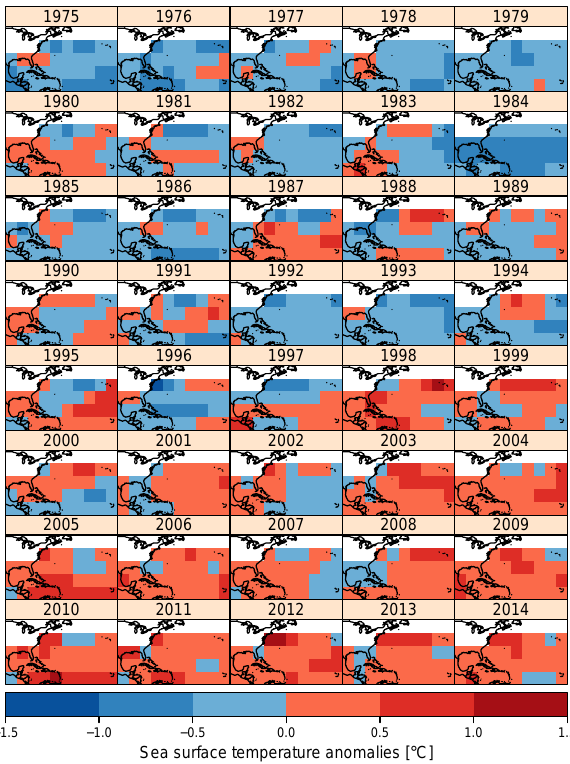
Figure 6. Yearly mean SST anomalies. Mean SST values are calcu- lated over the period June–October for each year 1975–2014. Yearly mean SSTs < 20 ◦ C are omitted from being plotted.